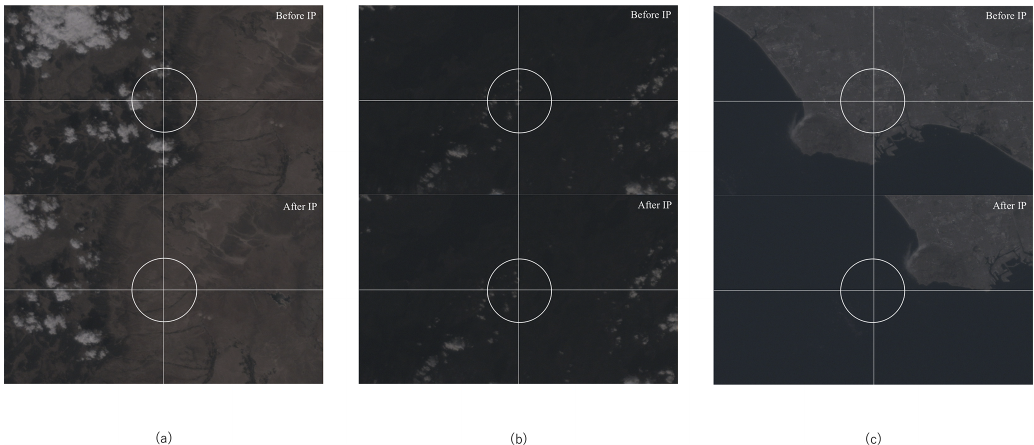
Figure 21. Typical images for successful and failed intelligent pointing (upper: before intelligent pointing; lower: after intelligent pointing; FOV: white circle). (a) Successful cloud avoidance through intelligent pointing. (b) Failed repointing due to scene darkness; FOV remains cloud contaminated. (c) Failed repointing from bright city to dark